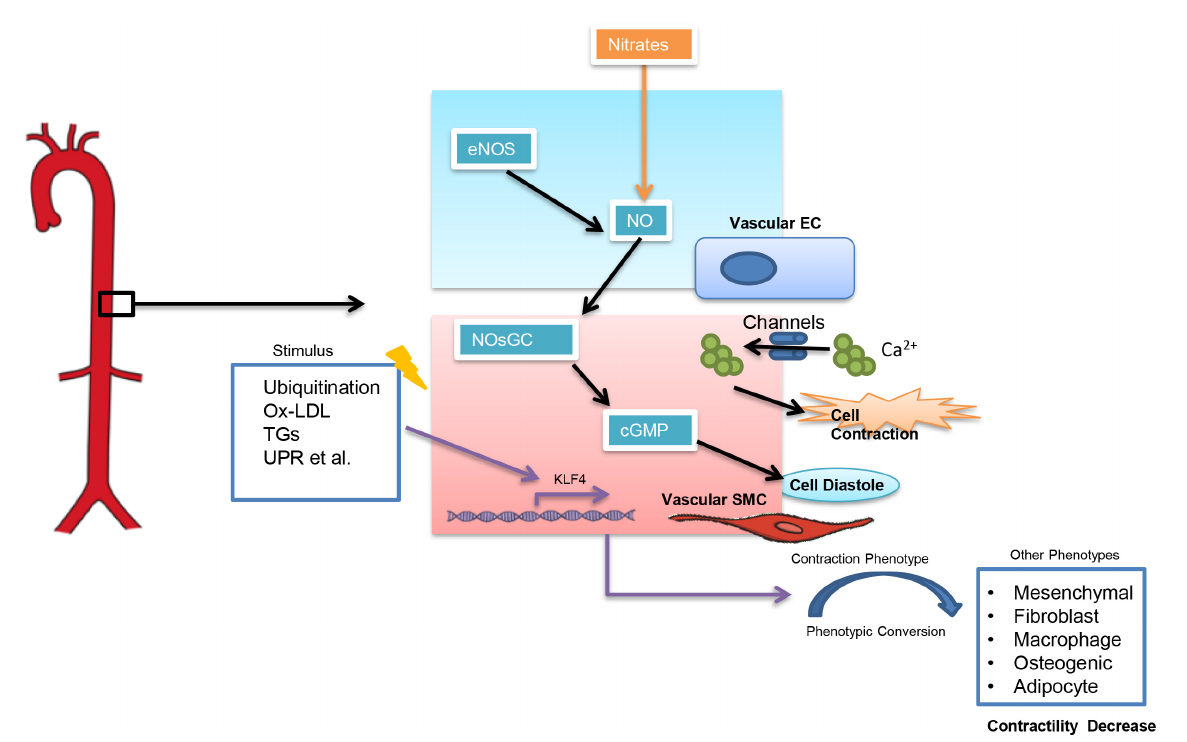
FIGURE1 Factors influencing the contractile function of smooth muscle cells. Ox-LDL, Oxidized low-density lipoprotein; TGs, Triglycerides; UPR, unfolded protein response; KLF4, Krüppel-Like Factor 4.